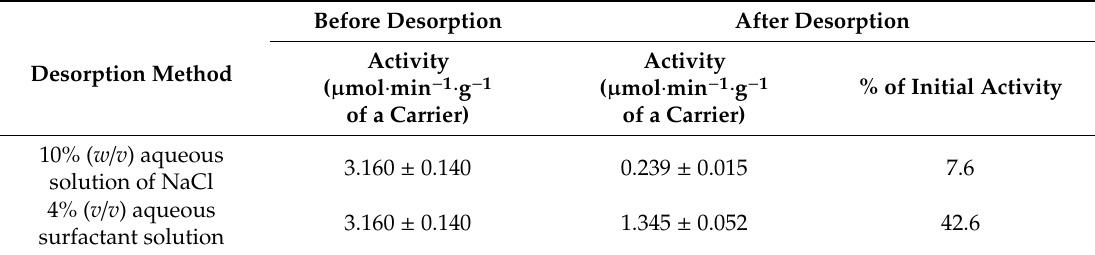
Table 1. Desorption of enzymatic protein from a polysaccharide magnetic carrier activated by